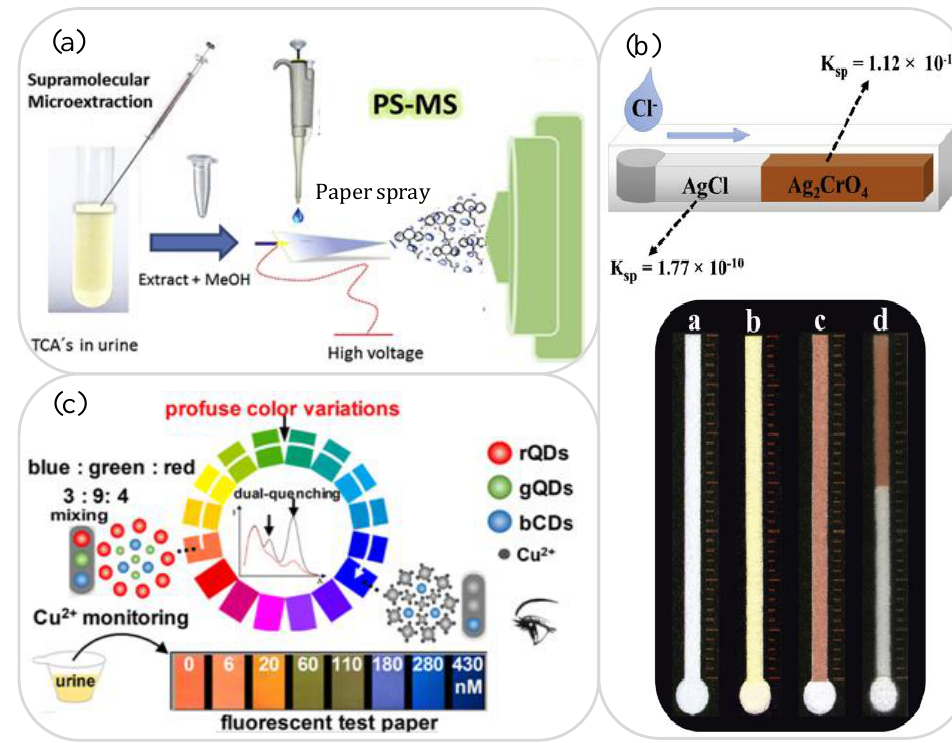
Figure 5. ( a ) Paper spray ionization mass spectrometry detection device for sensitive determination of tricyclic antidepressants in urine. Reprinted with permission from ref. [137]. Copyright 2020 Elsevier. ( b ) Lab-on-paper device based on argentometric distance-based for the detection of chloride ion concentration. Reprinted with permission from ref. [143]. Copyright 2019 Elsevier. ( c ) Lab-on-paper device with fluorescent sensor for visual detection of Cu 2+ using three-color probe. Reprinted with permission from ref. [146]. Copyright 2018 Elsevier.